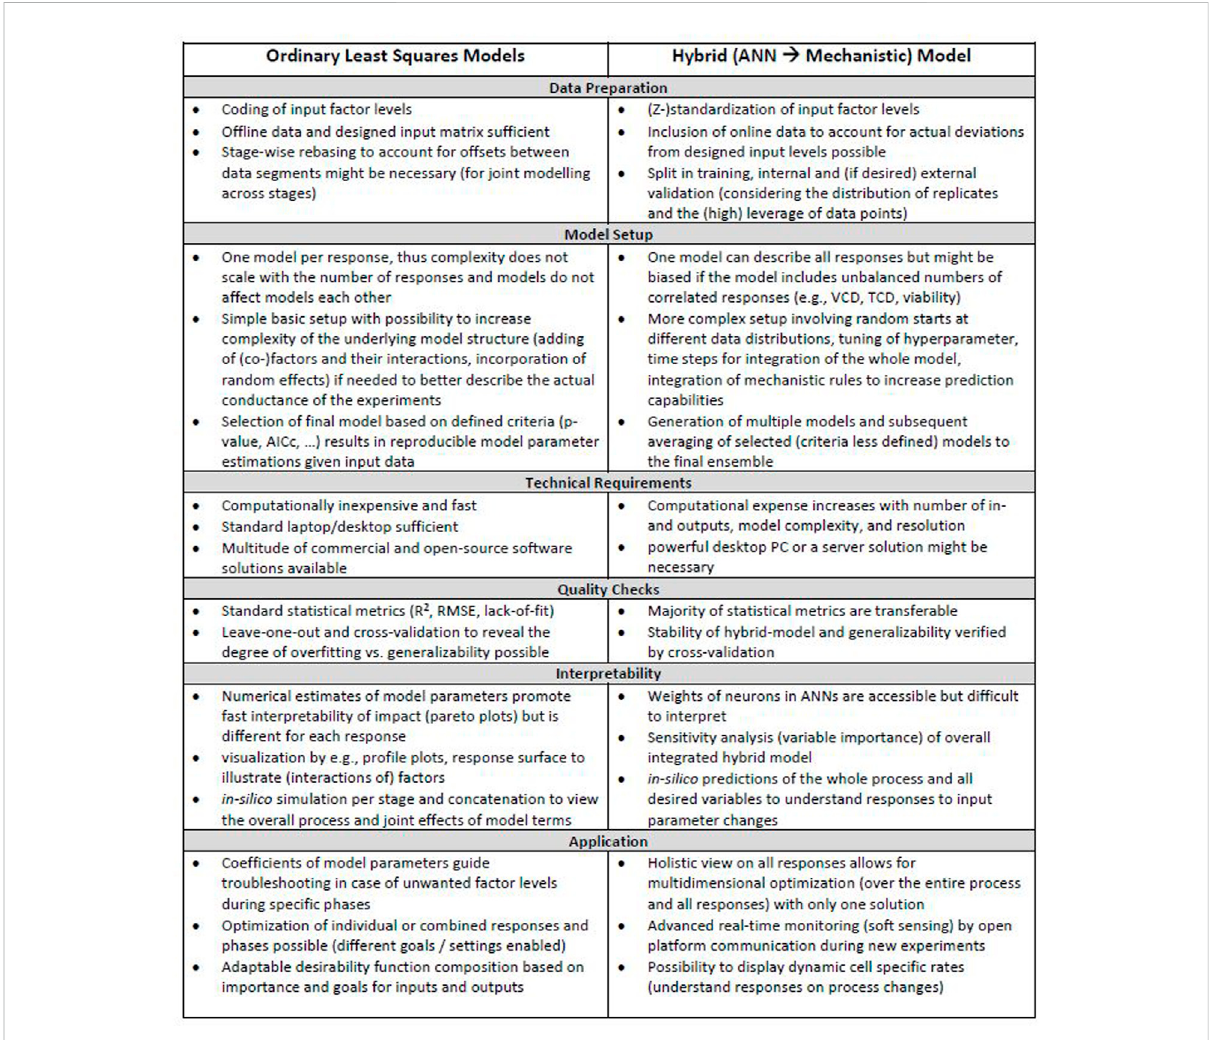
FIGURE 6 Considerations during OLS and HM work fl ows. Different aspects that need to be considered for OLS and hybrid modeling in the context of iDoE-derived data are provided for each step within the work fl